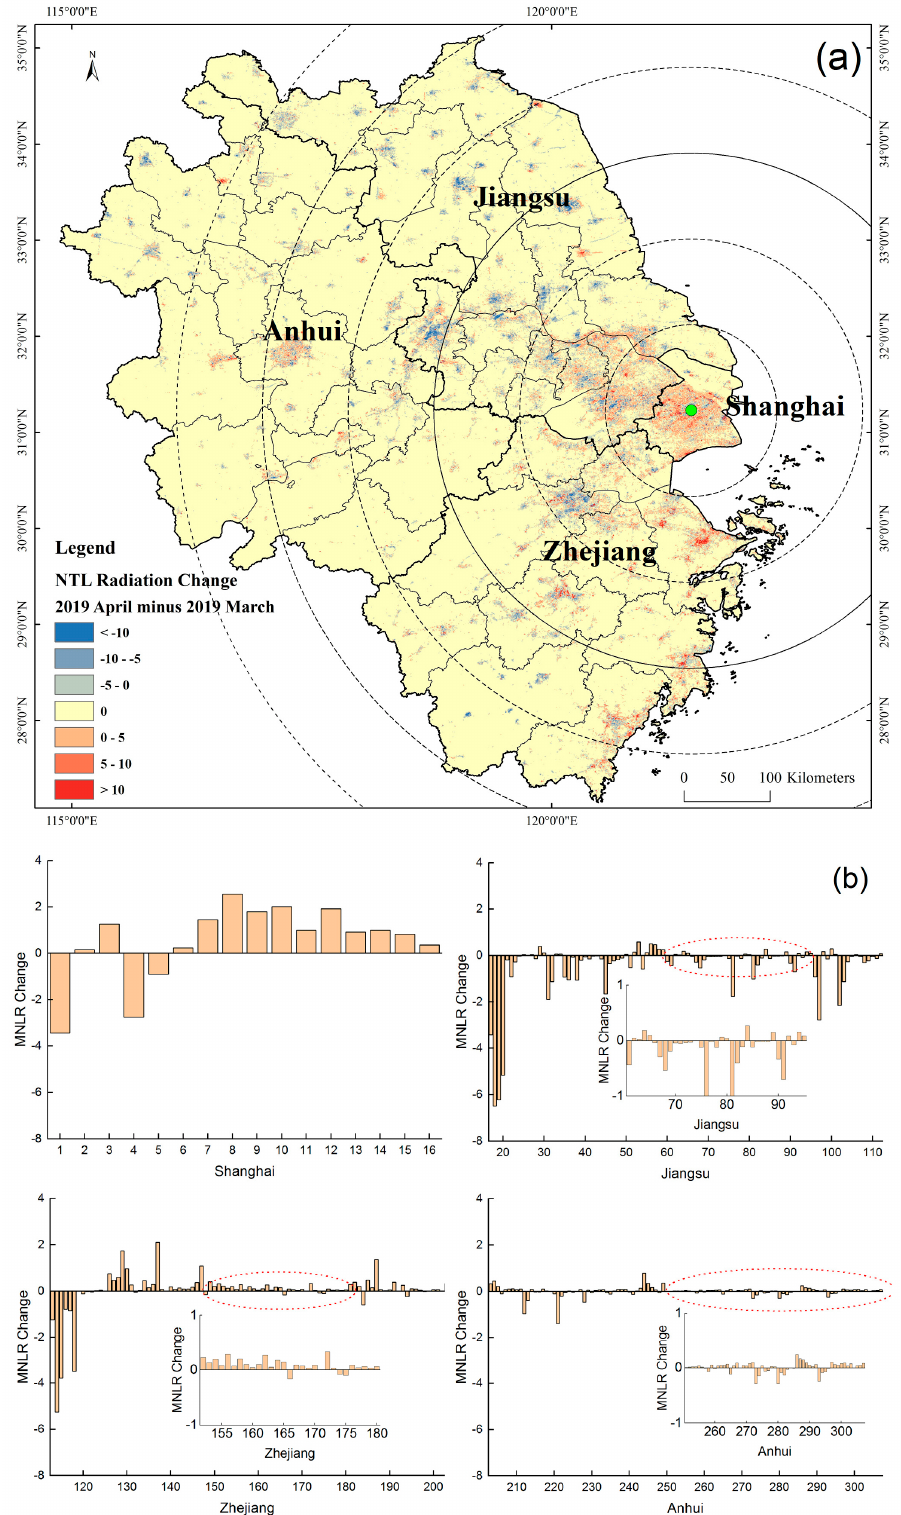
Figure 3. Spatio-temporal variation of MNLR from March to April 2019: ( a ) spatio-temporal variation of MNLR in the Yangtze River Delta; ( b ) MNLR changes of 307 counties in the Yangtze River Delta (Shanghai, Jiangsu, Zhejiang and Anhui). The serial number of the horizontal axis is arranged according to the county code. The red dashed box shows the portion with smaller values, which we have